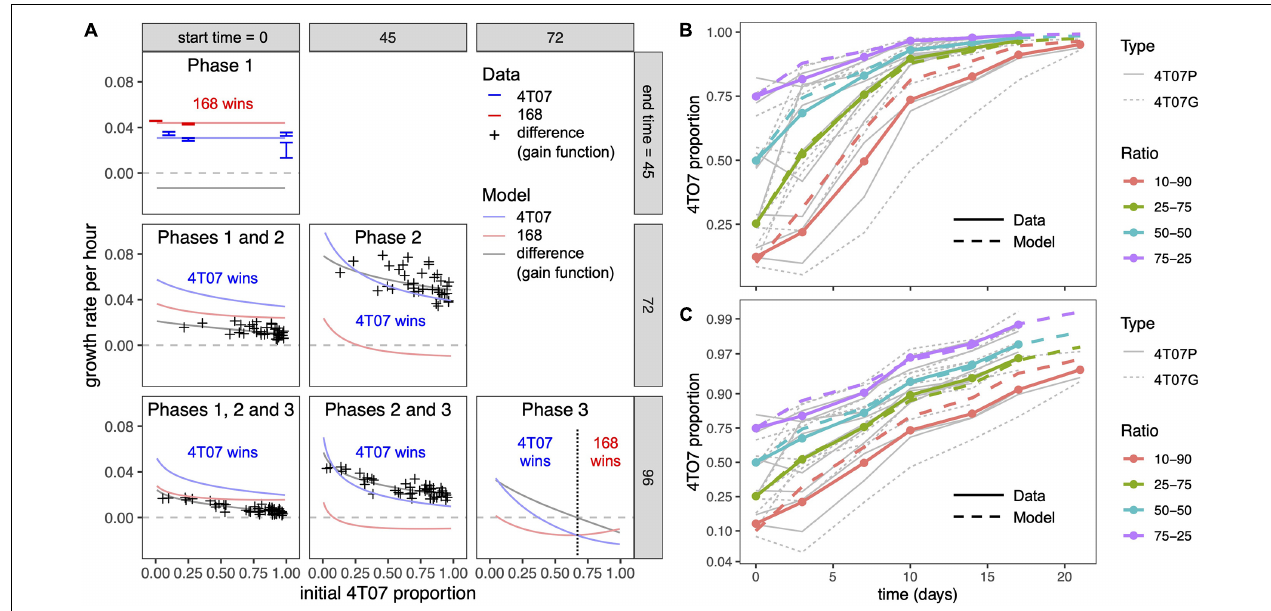
FIGURE 2 | Mean net growth rate differences according to mathematical model and experimental data. (A) Inferred mean net growth rates and mean net growth rate differences (gain functions) over different time periods, corresponding to different phases within competition assays. Columns correspond to different start times and rows to different end times of the phase(s) under consideration. For example, the center panel labeled “Phase 2” corresponds to the period between 45 and 72 h. The initial 4T07 proportion (horizontal axis) is measured at the start of the respective period and the growth rate (vertical axis) is averaged over the period. Phase 1 data are from time-lapse microscopy. Other data points in the first column are from serial competition assays, such that each point corresponds to the slope of a thin gray line in panel (B) . Data points in the middle column are obtained from the competition assay data by adjusting for exponential growth during phase 1 (see section “Materials and Methods”). Curves are the results of our mathematical model (see section “Materials and Methods”) with parameter values inferred from data ( Table 1 ). (B) 4T07 frequency dynamics across serial competition assays. Thick solid lines are averaged data (means of replicates with similar initial 4T07 proportions) and thick dashed lines are results of our mathematical model with parameter values inferred from data. Thin gray lines are data for individual experiments. A total of 10 5 cells were seeded in co-cultures and harvested and replated as indicated. 4T07 parental cells were transduced either with an empty retroviral vector (4T07P) or labeled with a GFP-encoding retrovirus (4T07G). The ratios of GFP to unlabeled cells were estimated by flow cytometry. (C) Logit-transformed 4T07 frequency dynamics. This panel shows the same data as panel (B) but with a logit-transformed vertical axis so that the slope of